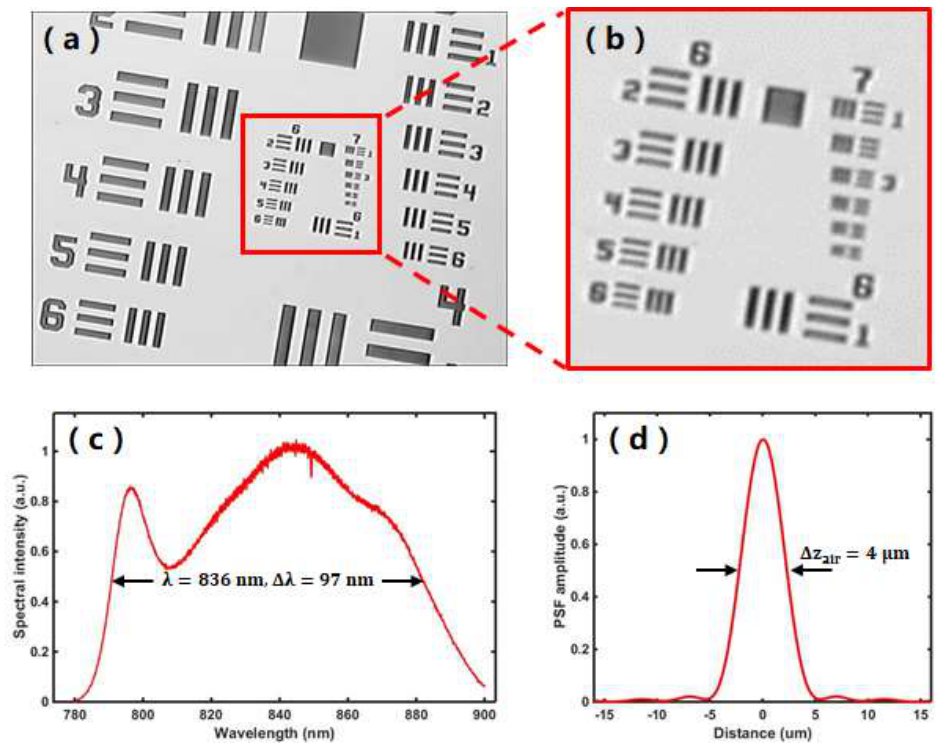
Figure 2. System performance characterization. ( a ) Representative image of the microvascular imaging module imaging a USAF resolution target with the highest magnification of 187.5x. ( b ) Zoom-in area of the red box area in ( a ), showing that element 2 of group 7 was readable, corresponding to a lateral resolution of 3.5 µ m. ( c ) Measured light source spectrum of the UHR-OCT system. ( d ) Measured axial point spread function (PSF) of the UHR-OCT system by imaging a mirror in air.